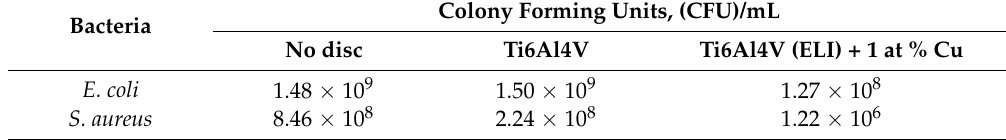
Table 2. Growth E. coli and S. aureus demonstrated after 24 h in the presence of Ti6Al4V and Ti6Al4V-1 at % Cu